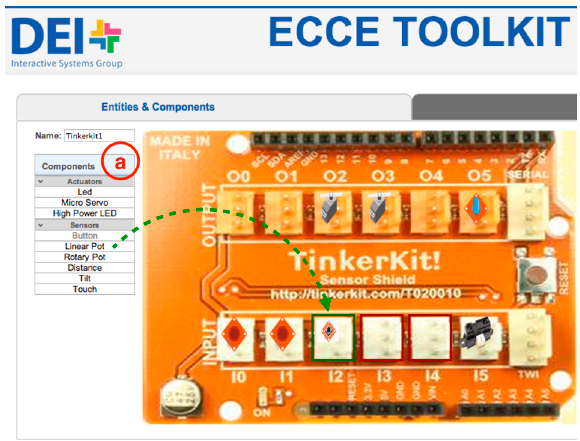
Figure 3. A screenshot of the web interface for the definition of Tinkerkit-based interactive entities. Users can ( a ) drag-and-drop sensors and actuators from a palette of components to the desired port.